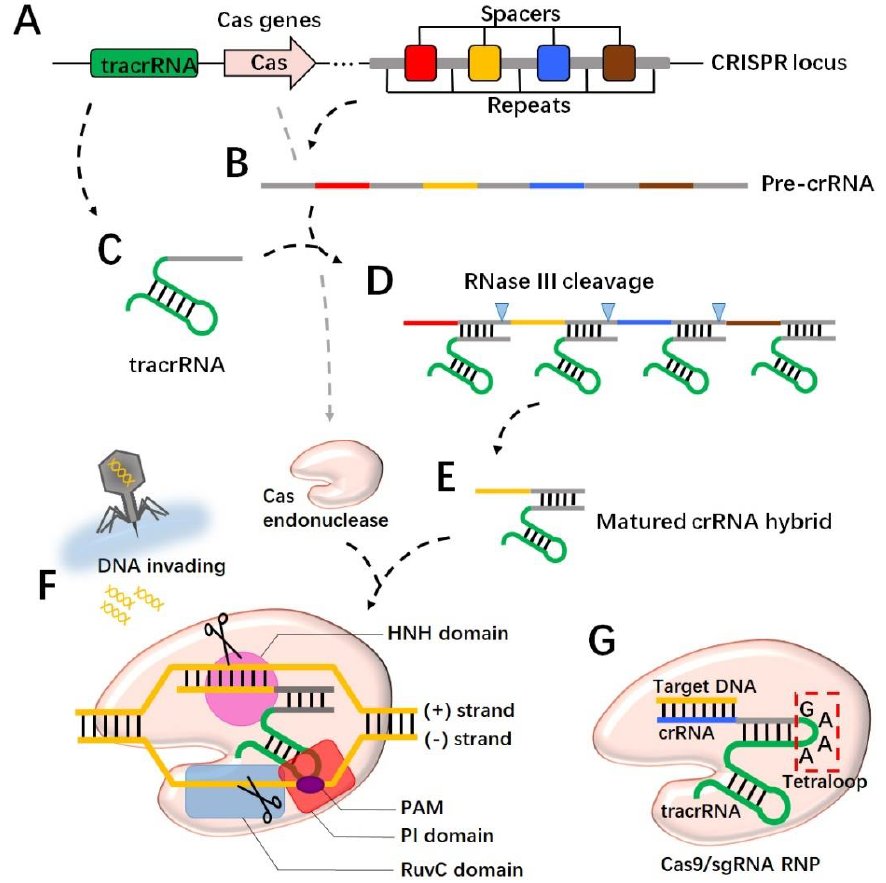
Figure 1. CRISPR cleaves DNA strands through RNA-guided Cas protein. The CRISPR locus in the prokaryotic genome has alternating spacers and repeats ( A ), which are transcribed for pre-crRNA ( B ). The tracrRNA is transcribed from a different locus in the genome ( C ) and binds to pre-crRNA through the complementary sequence to the repeat region ( D ). The binding with tracrRNA recruits RNase III, which trims pre-crRNA for matured crRNA ( E ). Cas endonuclease forms the ribonucleoprotein (RNP) with crRNA and targets the invading DNA through spacer sequence recognition ( F ). A PAM motif in the targeted DNA is required to activate Cas at the PI domain, and consequently the HNH domain and the RuvC domain cut the (+) and (−) strands of the DNA, respectively ( F ). In an engineered version, crRNA connects with tracrRNA to from single-guide RNA (sgRNA) by a 4 bp linker called a tetraloop ( G ). The spacer region is replaced to identify the target DNA. Together with Cas9, the RNP makes a double cut.